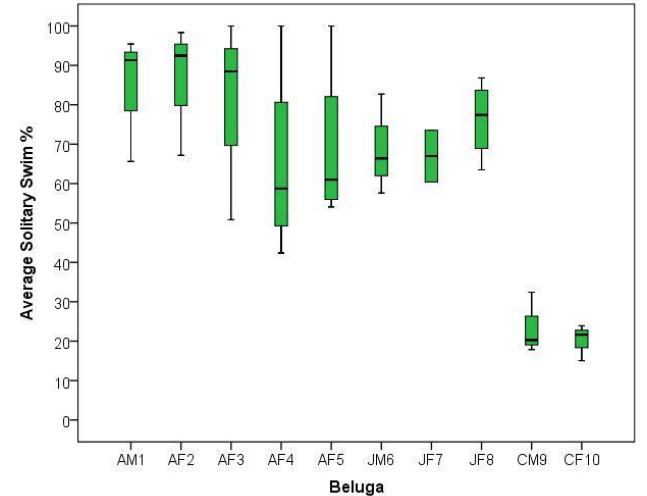
Figure 5. Boxplots of average solitary swim percentage per individual beluga. Note the scale is a 100%.